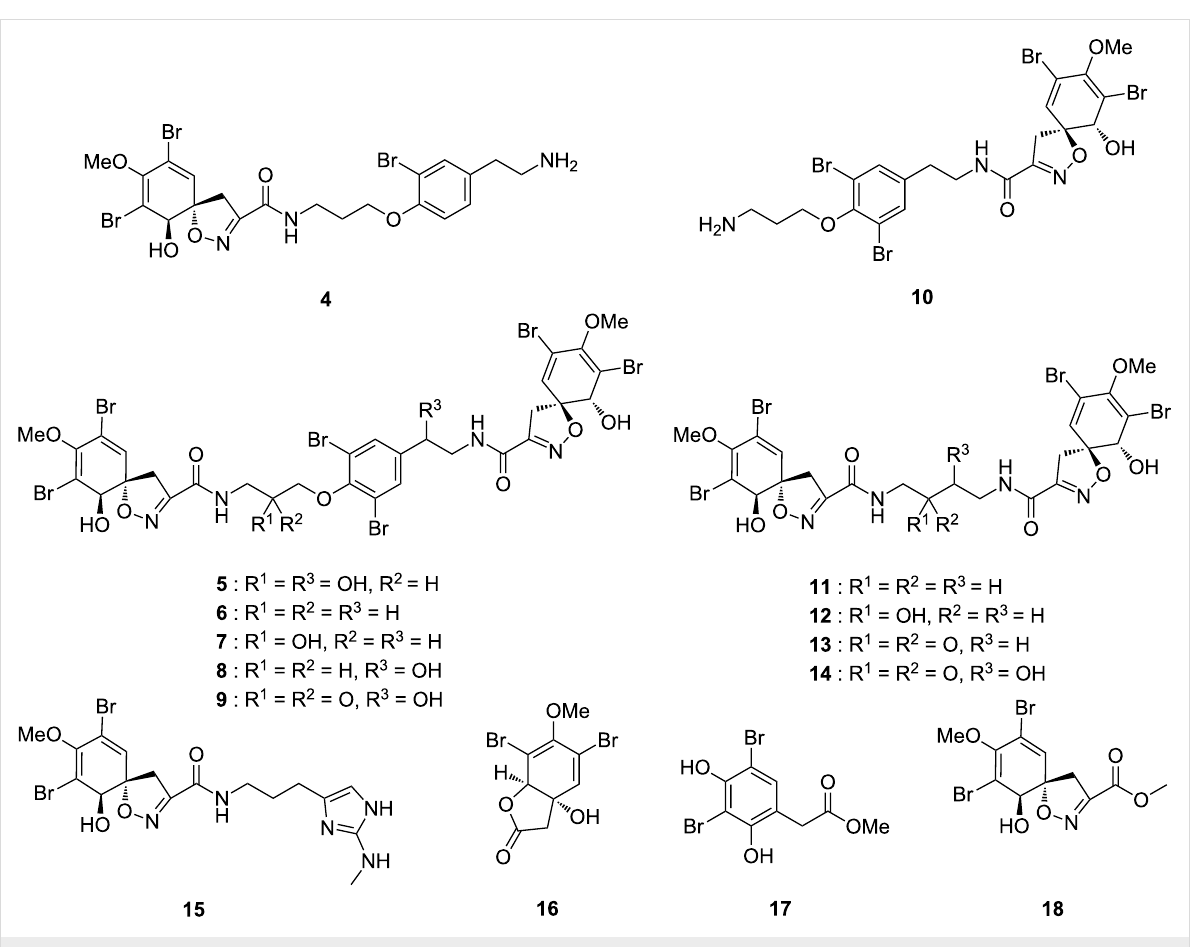
C-2´, C-6, and C-6´ of the two related compounds 11-deoxy- fistularin-3 ( 8 ) and 14-debromoaraplysilin I ( 4 ) [18] (Table 1 and Table 2,